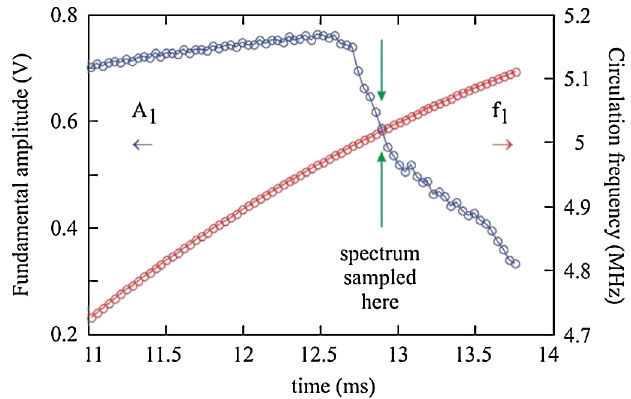
FIG. 2. (Color) FFT results when beam loss occurs, the width of time window is 37 : 5 (cid:1) s , data were taken at 12.88 ms after injection. USB: upper sideband. LSB: lower sideband.